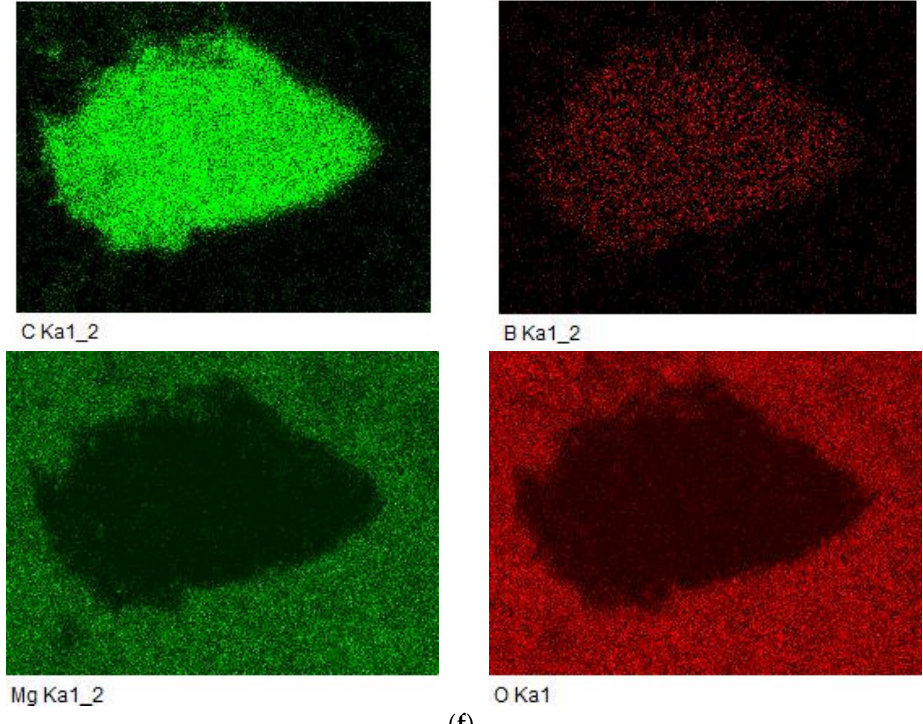
Figure 7. SEM for the control group without modifiers:( a ) pore of sample MOS-KDA; ( b ) pore of sample MOS-N; ( c ) matrix MOS-KDA; ( d ) matrix MOS-N; ( e ) magnesium oxysulfate matrix; ( f ) EDS spectrum of magnesium oxysulfate matrix.